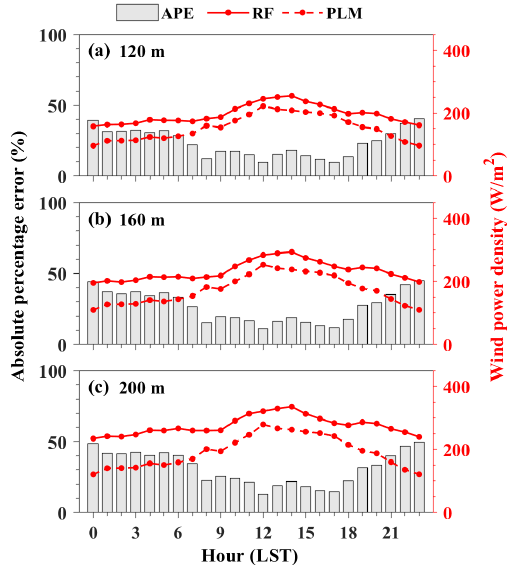
Figure 9. Diurnal variation in the wind power density (WPD) at (a) 120m, (b) 160m, and (c) 200m. The solid and dotted red lines represent WPD from RF and the PLM, respectively. The gray bar represents the absolute percentage error (APE) of WPD between RF and the PLM.